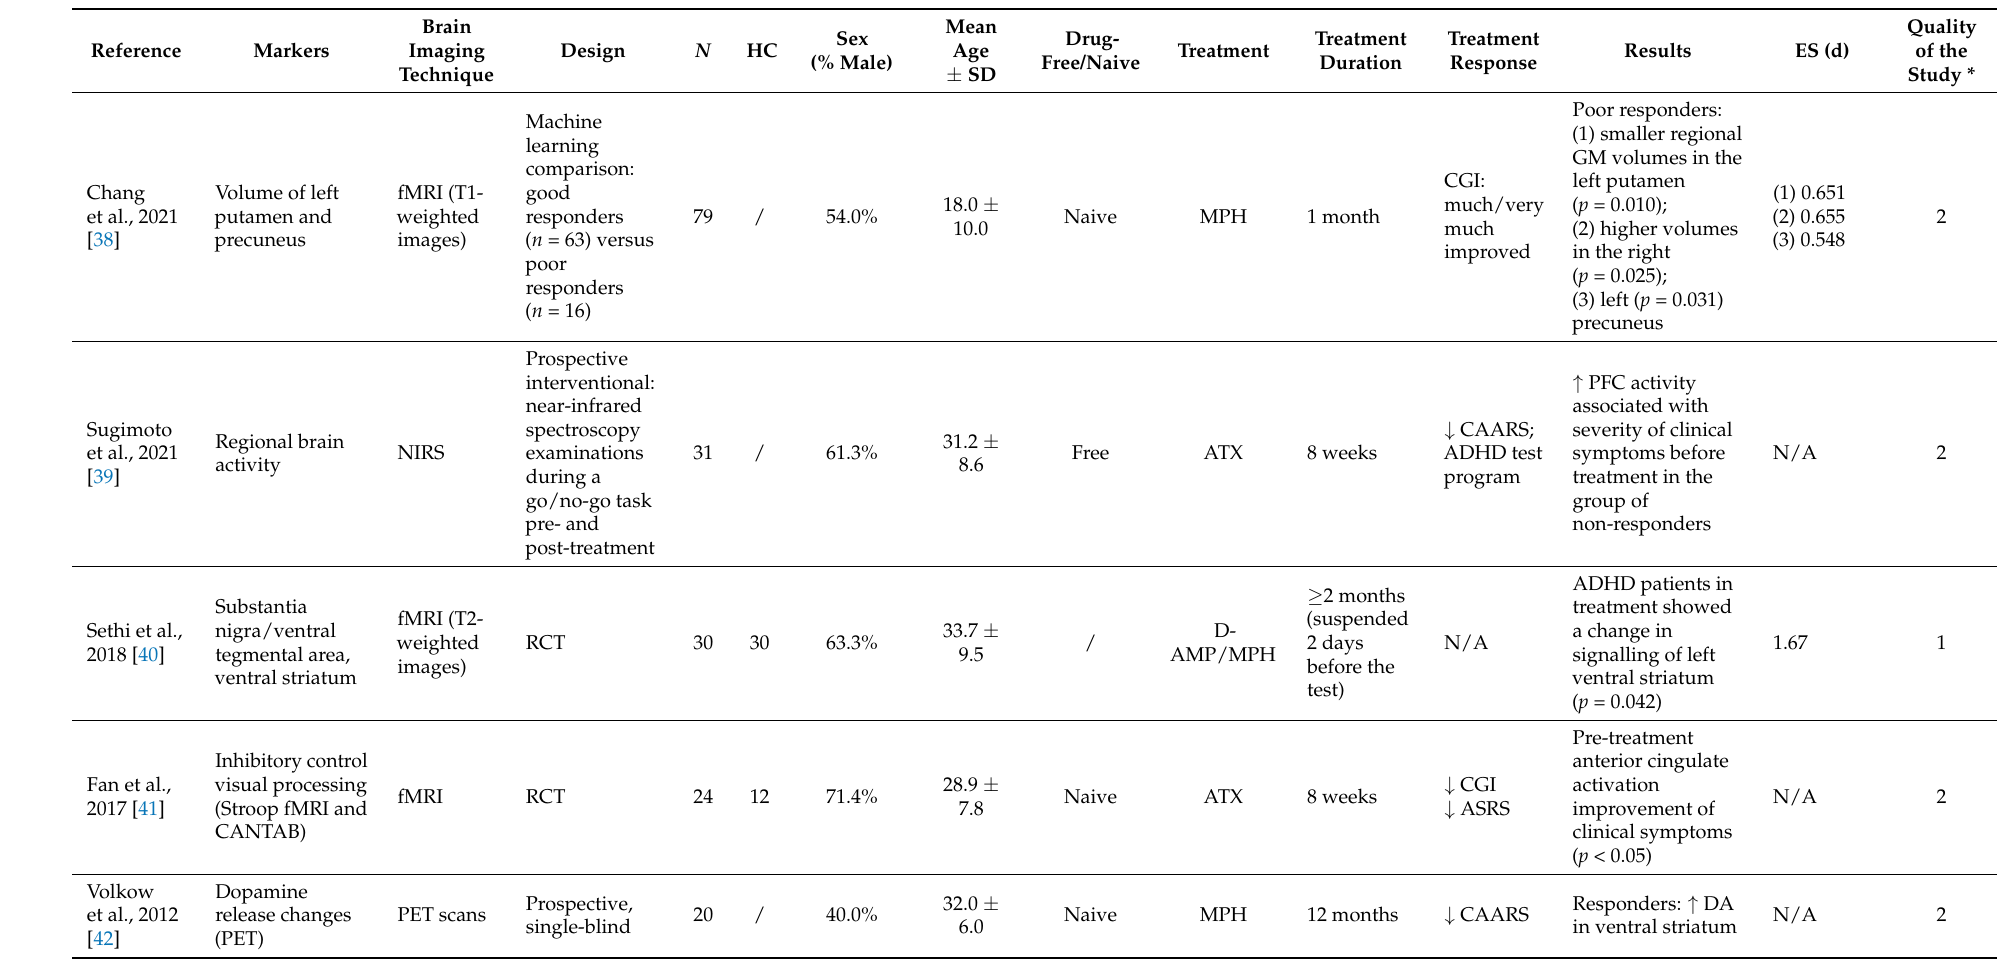
Table 2. Summary of the studies about neuroimaging markers of treatment response in adult